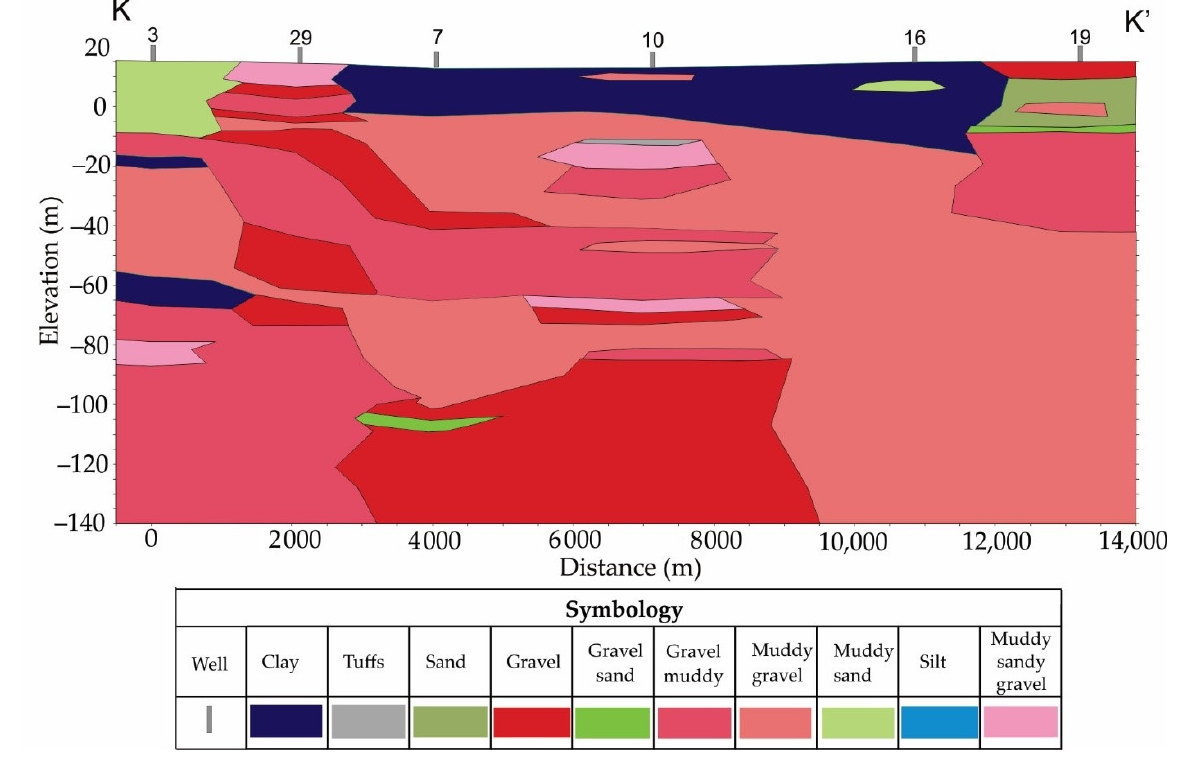
Figure 2. Hidrogeologycal cross section (K-K’) in six litological columns on the study area.